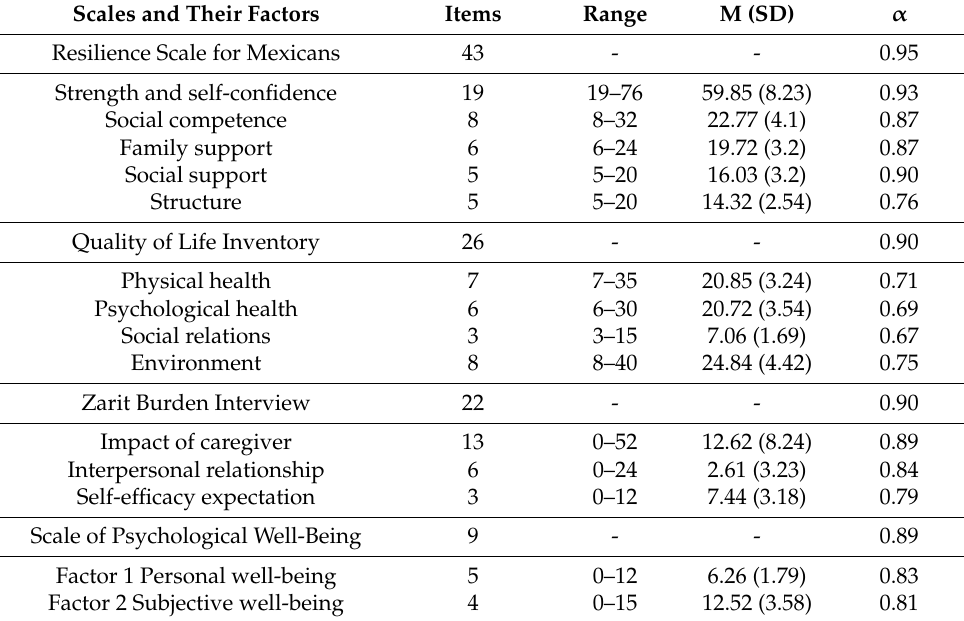
Table 1. Average scores obtained from the factors of each measurement instrument. Scales and Their Factors Items Range M (SD) α Resilience Scale for Mexicans 43 Strength and